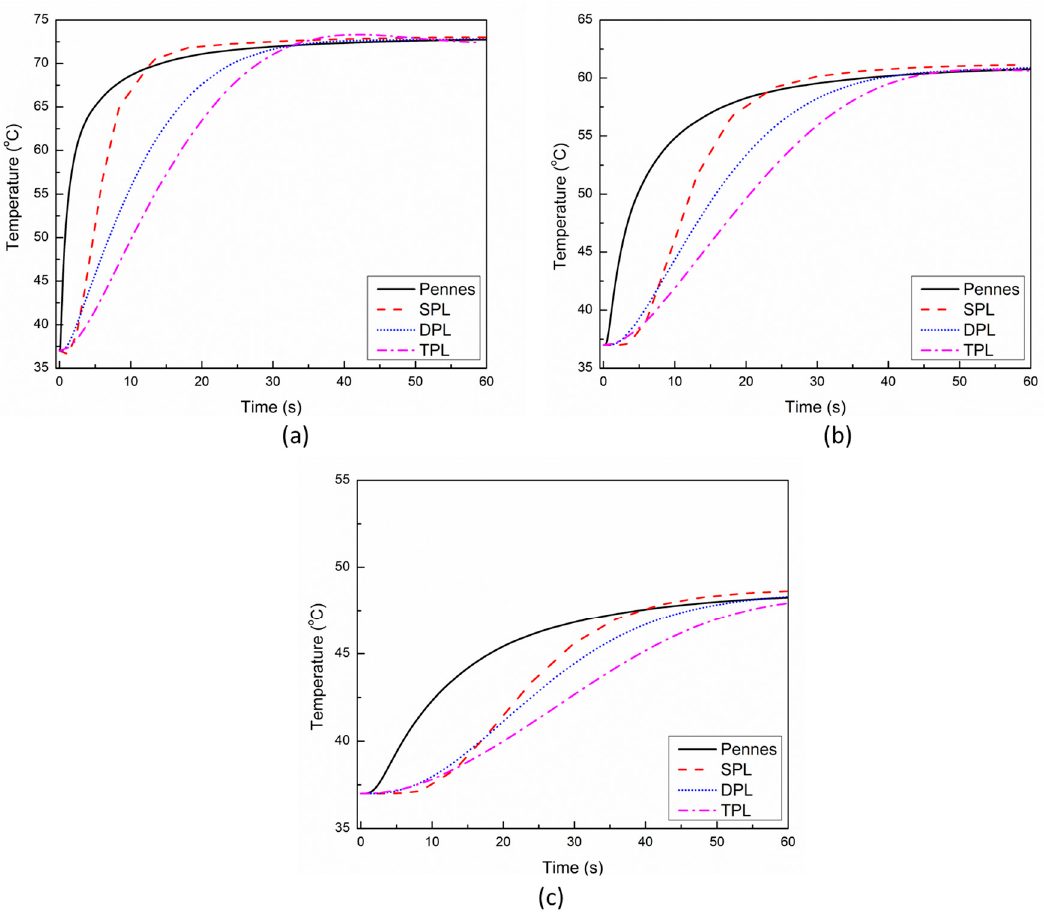
Figure 3. Temporal evolution of temperature predicted with different bio-heat transfer models at a location of: ( a ) 0.5 mm, ( b ) 1 mm, and ( c ) 2 mm below the tip of the applicator.